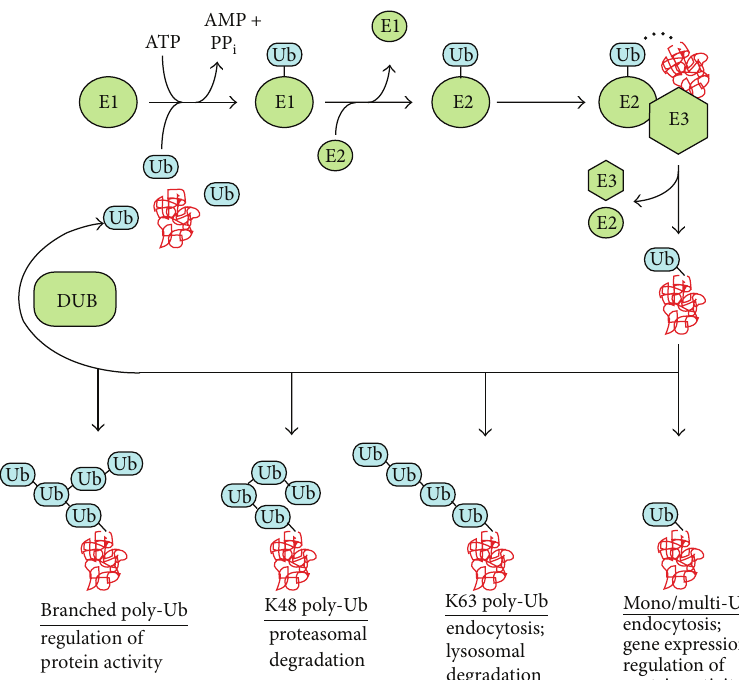
Figure 1: Ubiquitination and ubiquitin-mediated trafficking. Ubiquitin (Ub) is activated in an ATP-dependent manner by an E1, passed to an E2 ubiquitin conjugase, and finally transferred to a target protein by an E2/E3 ubiquitin ligase complex. Following monoubiquitination, the addition of further ubiquitin moieties occurs at specific lysine residues and results in one of a variety of polyubiquitin chains, each possessing a unique set of known consequences for protein regulation and trafficking. The ubiquitination state of a protein is regulated both via the addition of ubiquitin and also via the removal of single moieties or chains by deubiquitinases